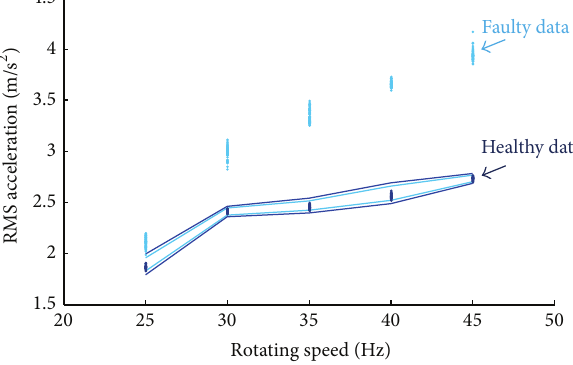
Figure 9: Baseline of the test rig operating at variable speed using the RMS value of the